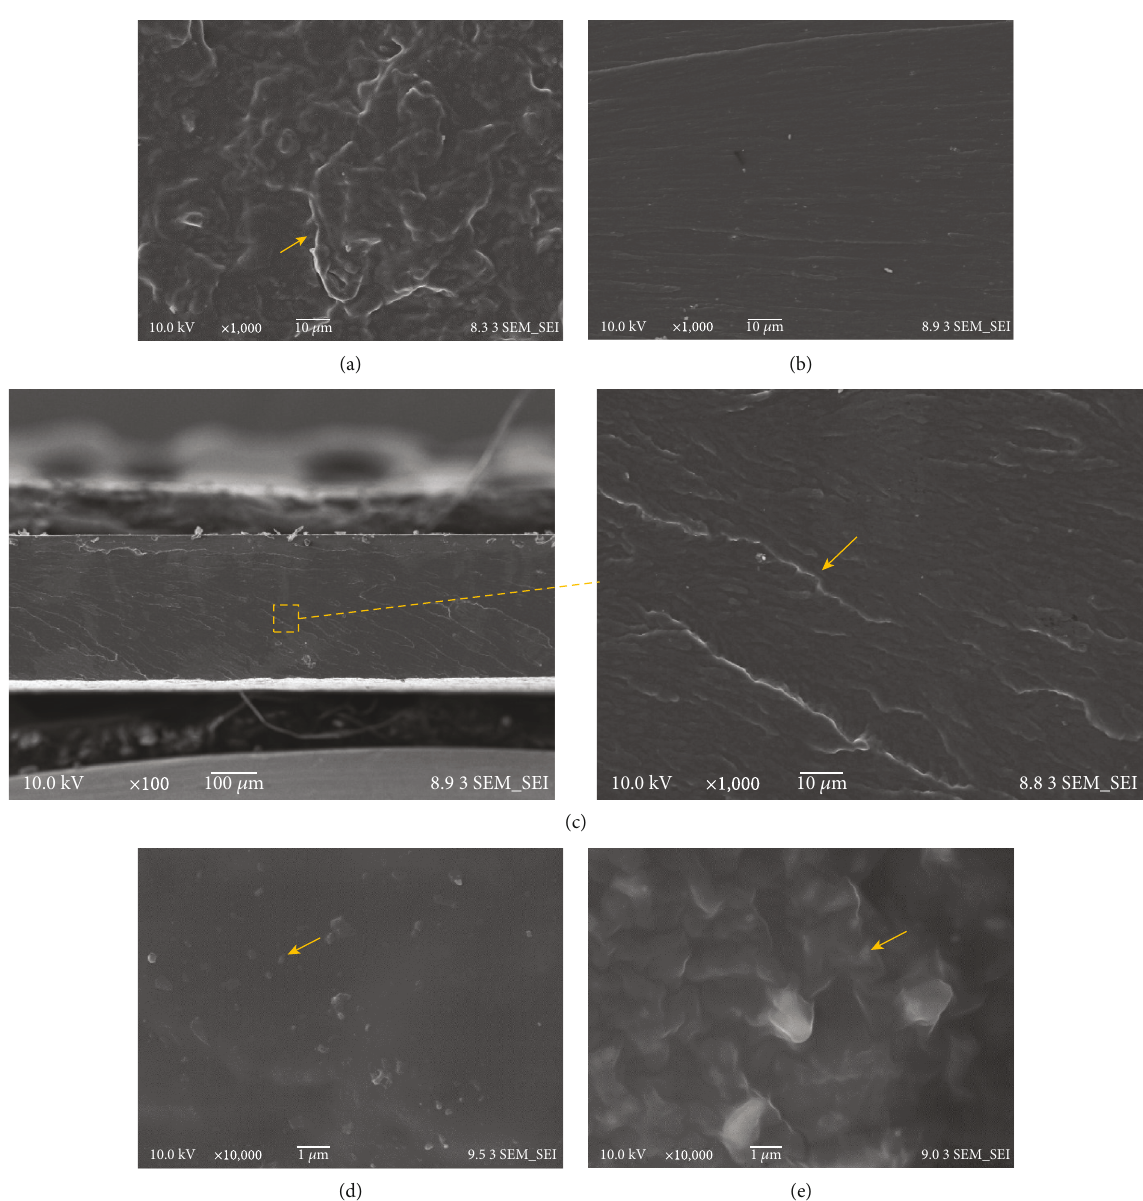
Figure 2: FESEM images of the fracture surface for the pure starch fi lm (a), pure chitosan fi lm (b), starch/chitosan fi lm (c), GU/CH/15BC fi lm (d), and GU/CH/20BC fi lm